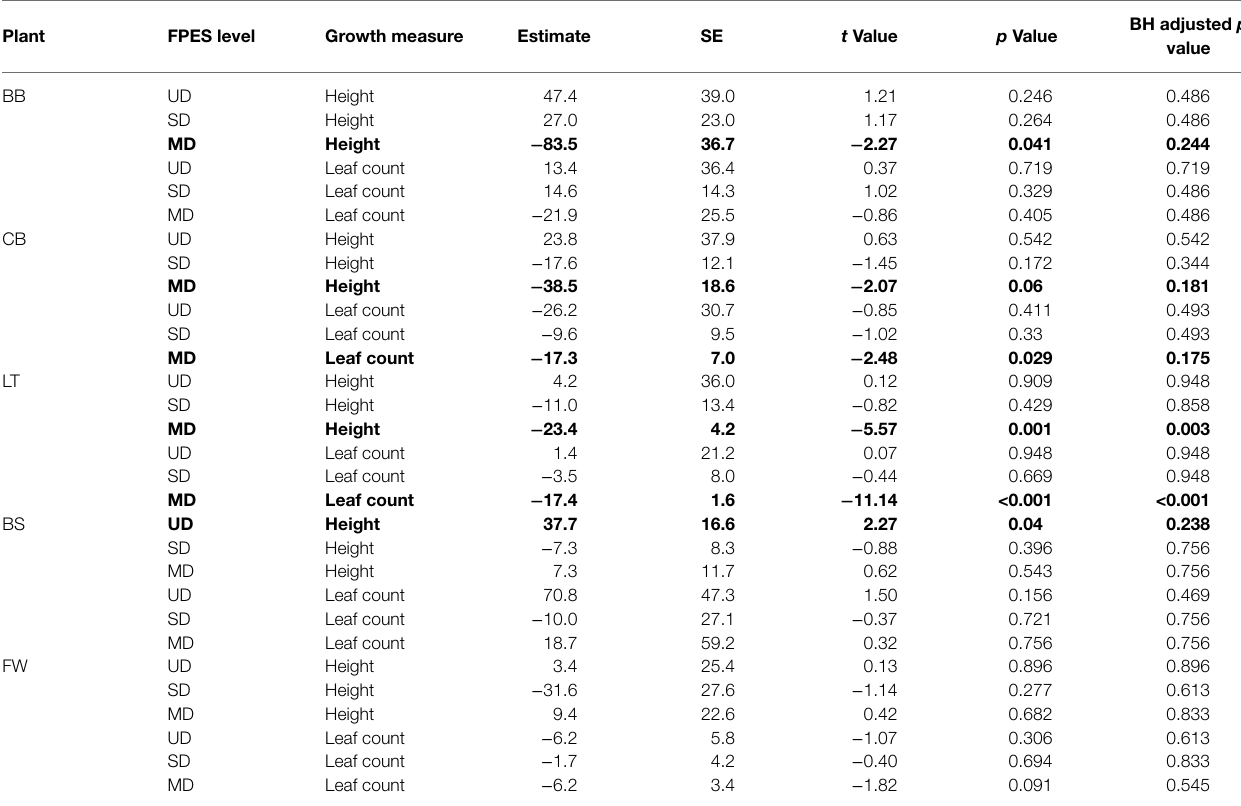
TABLE 3 | Results from linear models of plant growth measures predicted by 16S